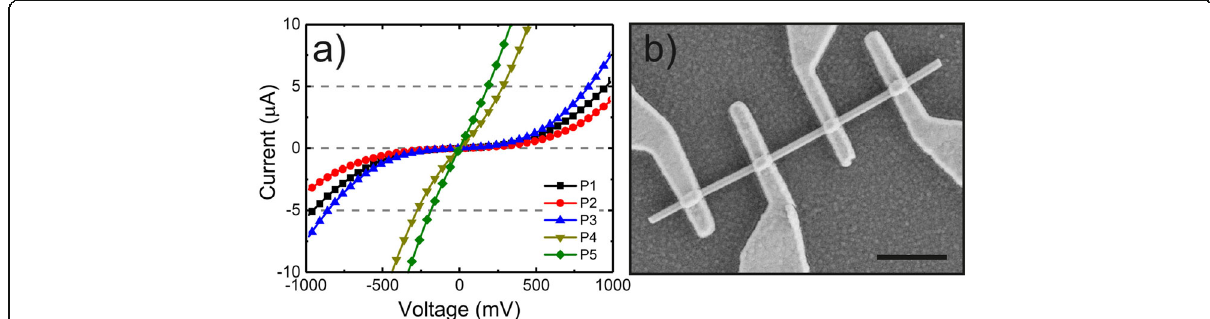
Fig. 1 a IV from Be-doped GaAs NWs with electrical contacts fabricated using the processes P1 – P5 as described in Table 1. b SEM image of a representative Be-doped GaAs NW with four evenly spaced electrical contacts. The scale bar is 1 μ m